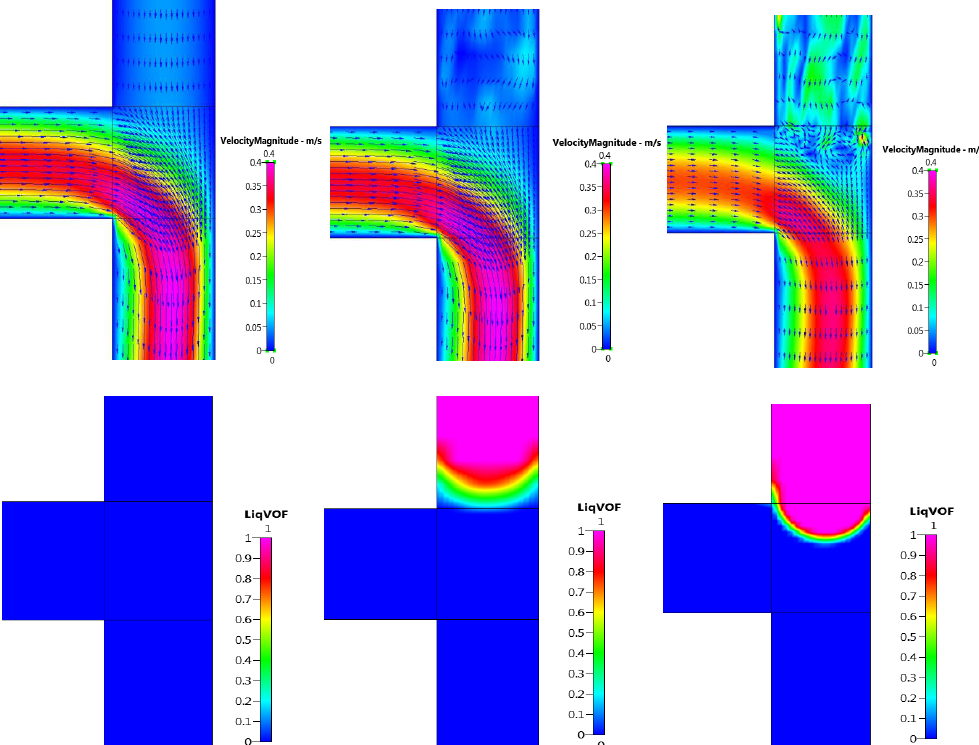
Figure 7. Velocity magnitude plots corresponding with various stages of gas column approaching the mixing region without application of the electric field.